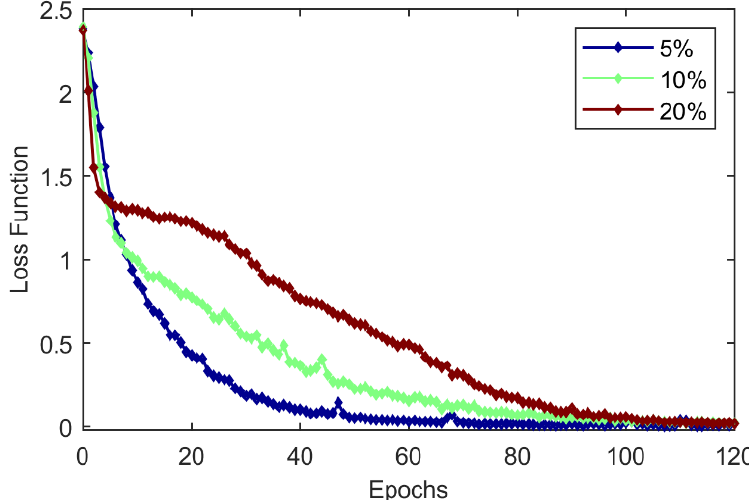
Figure 14. Training loss at different sample noise levels.